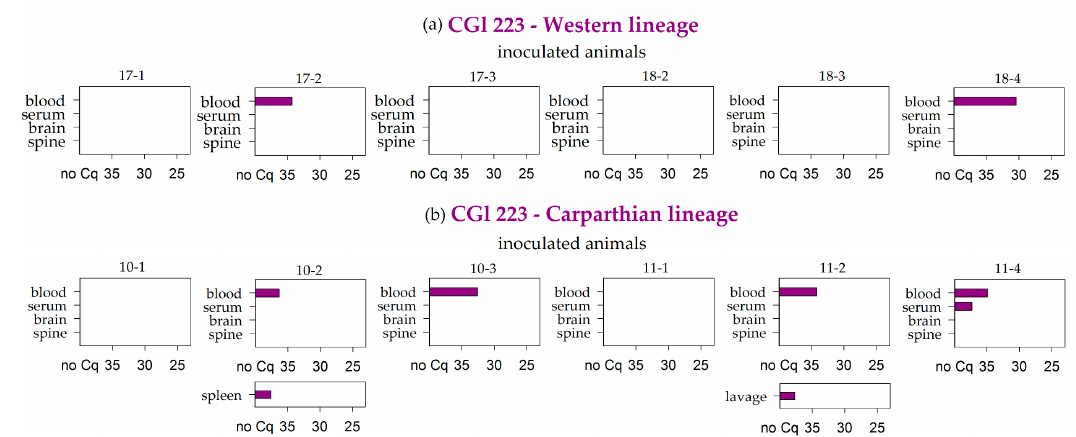
Figure 3. RT-PCR results of blood, serum, brain, and spine samples for the bank voles of the Western ( a ) Figure 3 and Carparthian ( b ) lineage that were inoculated with the CGl 223 TBEV-Eu strain. Further additional positive samples are listed per animal. Measures are given in quantification cycle values (Cq).